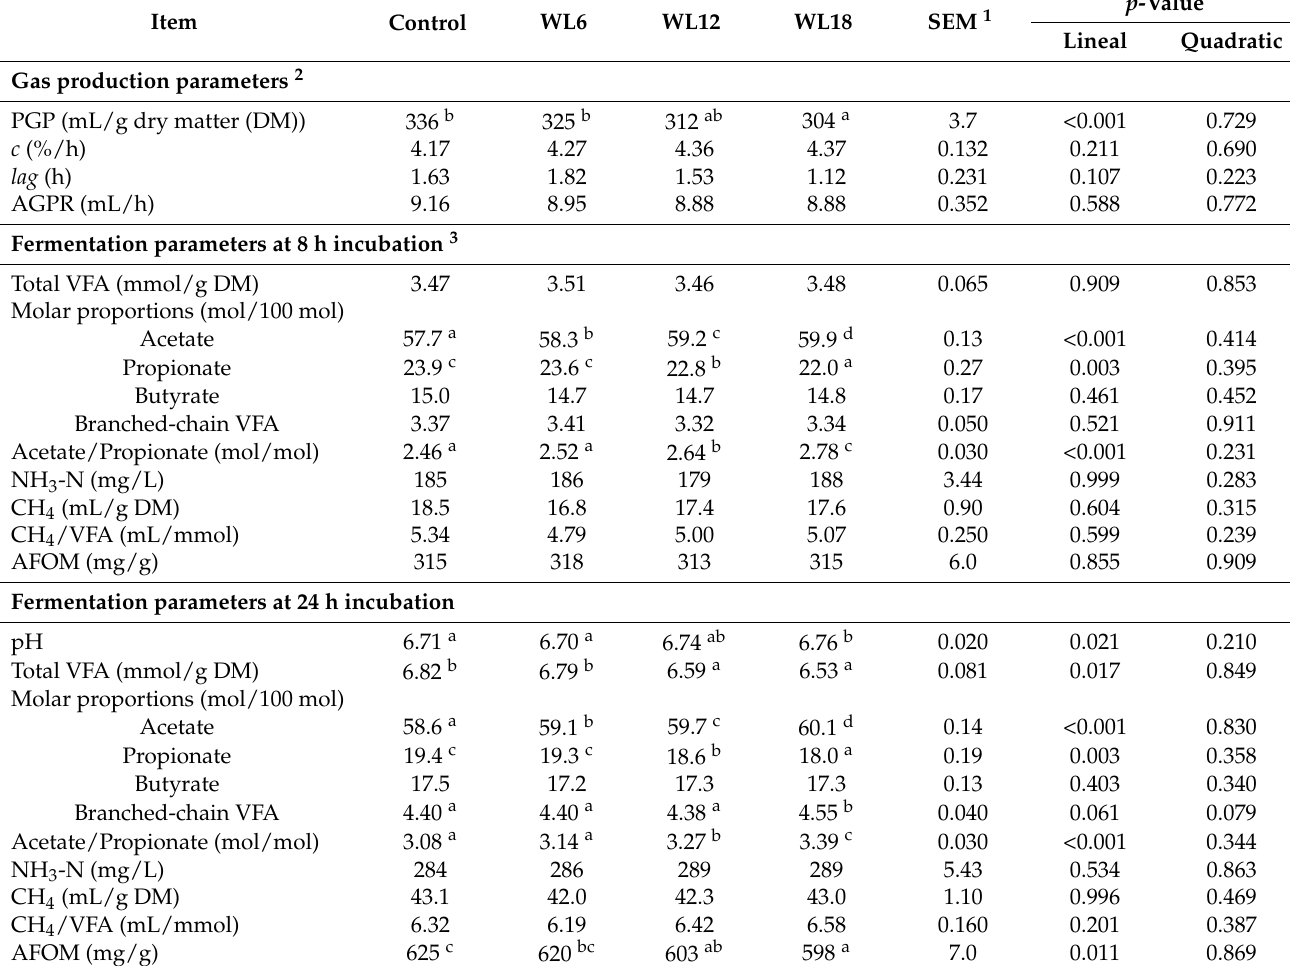
Table 3. Gas production parameters and fermentation parameters after 8 and 24 h of in vitro